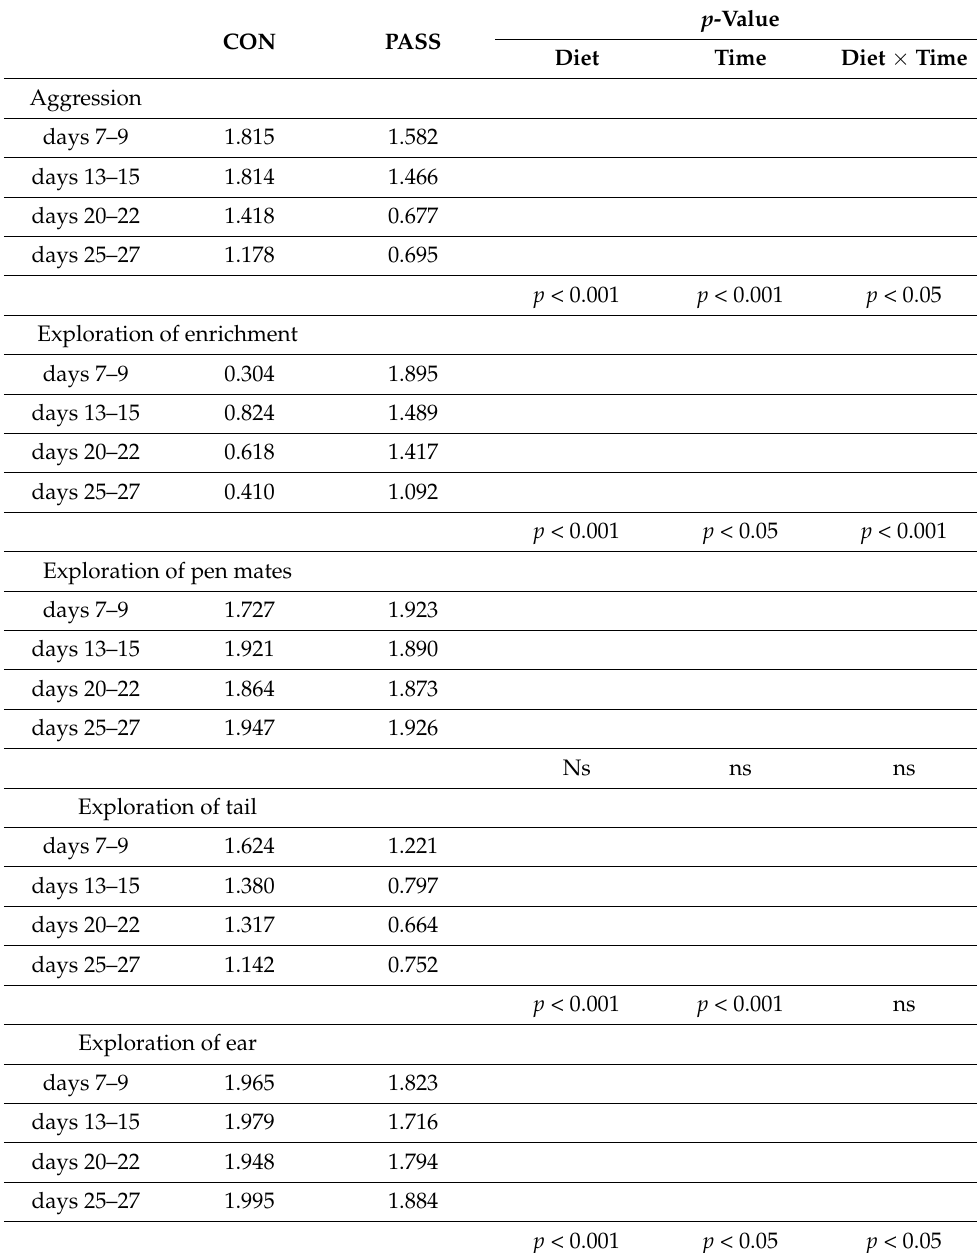
Table 5. Total occurrence of selected behaviors, expressed as Log, in piglets fed the control diet (CON) or diet supplemented with Passiflora incarnata powder extract (PAS). p -Value CON PASS Diet Time Diet ×